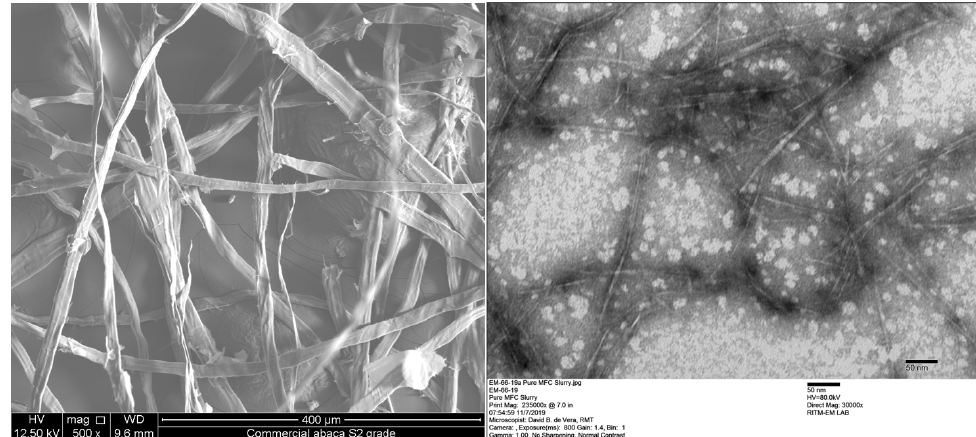
Figure 2. Extraction of nanocellulose ( a ) abaca fiber and ( b ) nanocellulose.